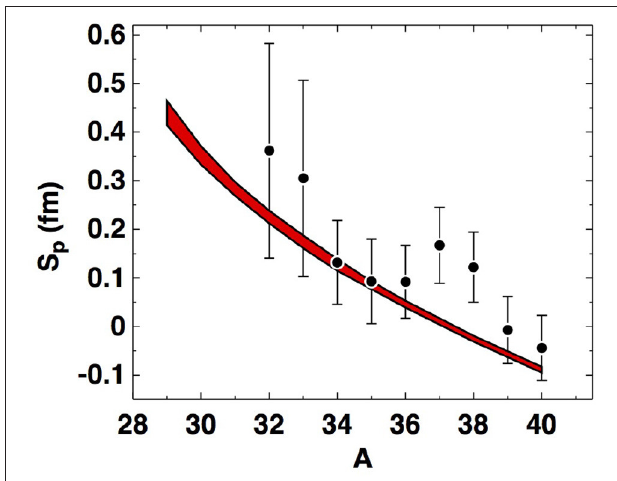
FIGURE 1 | (Color online) Predicted proton skins of Argon isotopes as a function of the mass number, A . The data points are from Ozawa et al. [ 53].